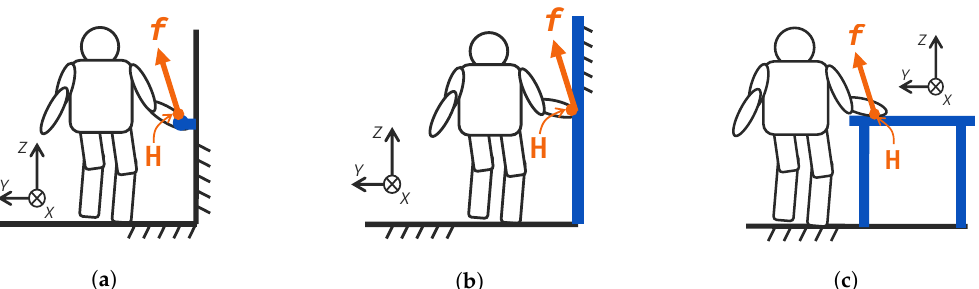
Figure 2. Nonportable support objects. ( a ) support object #1: handrail (cylindrical shape); ( b ) support object #2: wall (vertical-planar shape); and, ( c ) support object #3: table (horizontal-planar shape).